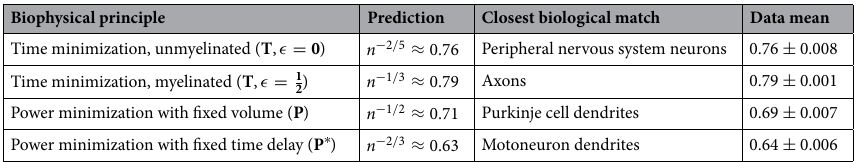
Table 1. Results for radius scaling ratio theoretical